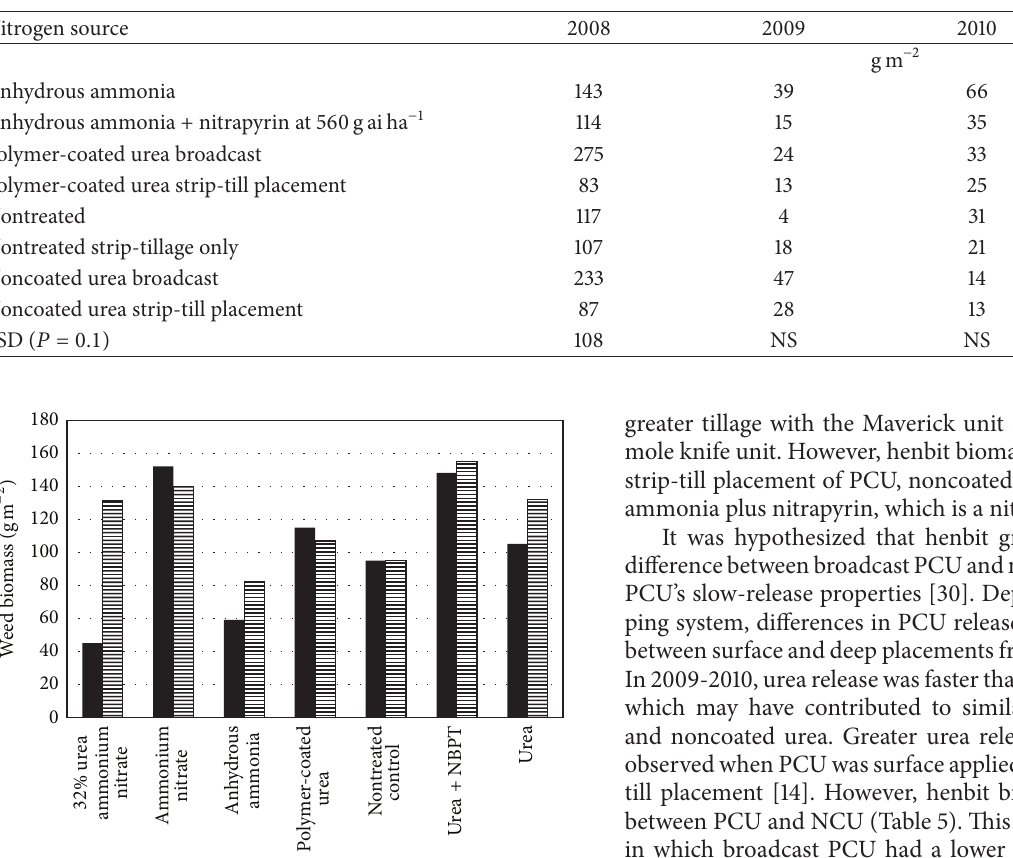
Table 5: Henbit biomass prior to a burndown herbicide application as affected by nitrogen fertilizer source and fertilizer placement in 2008, 2009, and 2010. Data were averaged over N application timings.